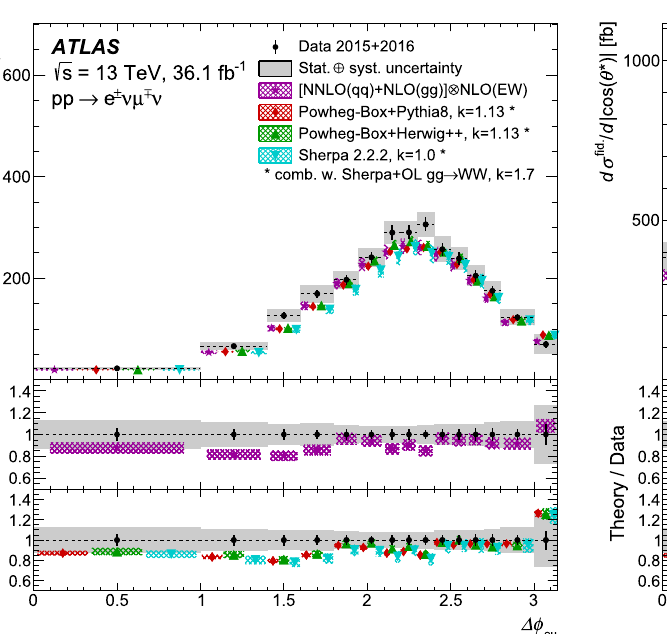
Box + Herwig++ and Sherpa 2.2.2 for q ¯ q initial states, combined with Sherpa + OpenLoops (LO+PS) for the gg initial states. All three q ¯ q NLO+PS predictions are normalized to the NNLO theoretical predic- tion for the total cross-section, with the gg LO+PS contribution nor- malized to NLO. Theoretical predictions are indicated as markers with hatched bands denoting PDF+scale